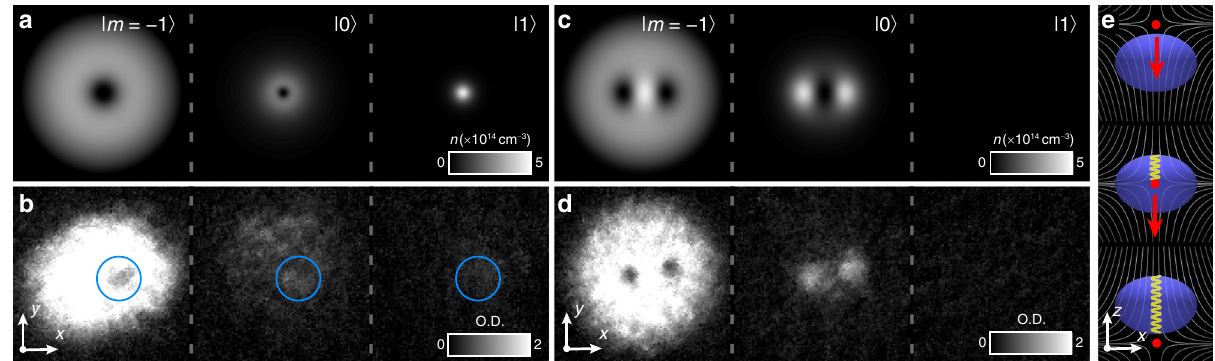
Fig. 3 Controlled singular SO(3) vortex creation from a non-singular vortex. a Spinor component densities of an analytically constructed non-singular vortex state immediately after imprinting (see also Supplementary Note 1) in a cross-section through the condensate. b Corresponding experimental absorption images with T evolve ≈ 0 ms for d B b /d t = − 5 G s − 1 . The density minimum of the m = − 1 component marks the non-singular vortex centre, and the other two components are non-zero in this region (blue circles). The creation process subjects the three spinor components to sustained differential forces, distorting the condensate and inducing non-zero densities in the m = 0 and m = 1 components distant from the vortex centre. The densities of the experimental images are expressed in terms of dimensionless optical depth (O.D.), and the fi eld of view of each image is 219 μ m × 219 μ m. c Locally stable state after numerically simulated energy relaxation of the non-singular vortex of b , shown as component densities in a cross-section through the cloud. As a consequence of the SO(3) order parameter symmetry and conserved magnetisation, the non-singular vortex is unstable towards splitting into a pair of singly quantised, singular vortices, visible as density dips in the m = − 1 component. Peaks in the m = 0 component at the positions of the vortices show the formation of vortex cores fi lled with atoms in the polar phase. d As b , but for T evolve = 150 ms and corresponding to c . e Schematic of the imprinting process, showing the condensate (blue), magnetic fi eld lines (grey), nodal line/axis of coreless vortex (yellow), and location of the magnetic fi eld zero (red dot) at three sequential instants in time. The non-singular vortex is created by incompletely adiabatic spin rotations as the location of the fi eld zero passes through the condensate in the direction of the red arrow. Source data are provided as a Source Data fi